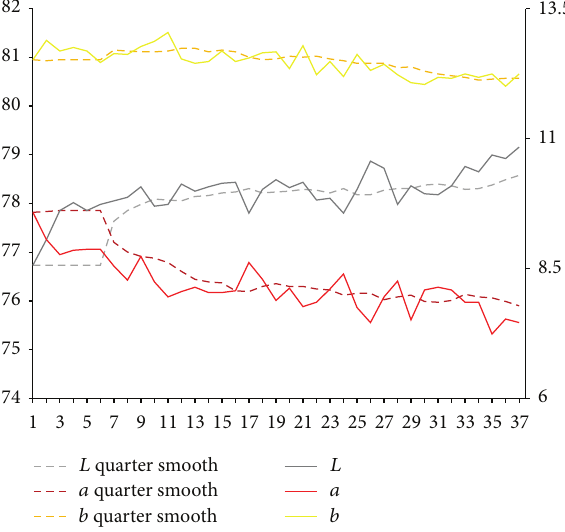
Figure 8: Lab value changing trend of left cheek.